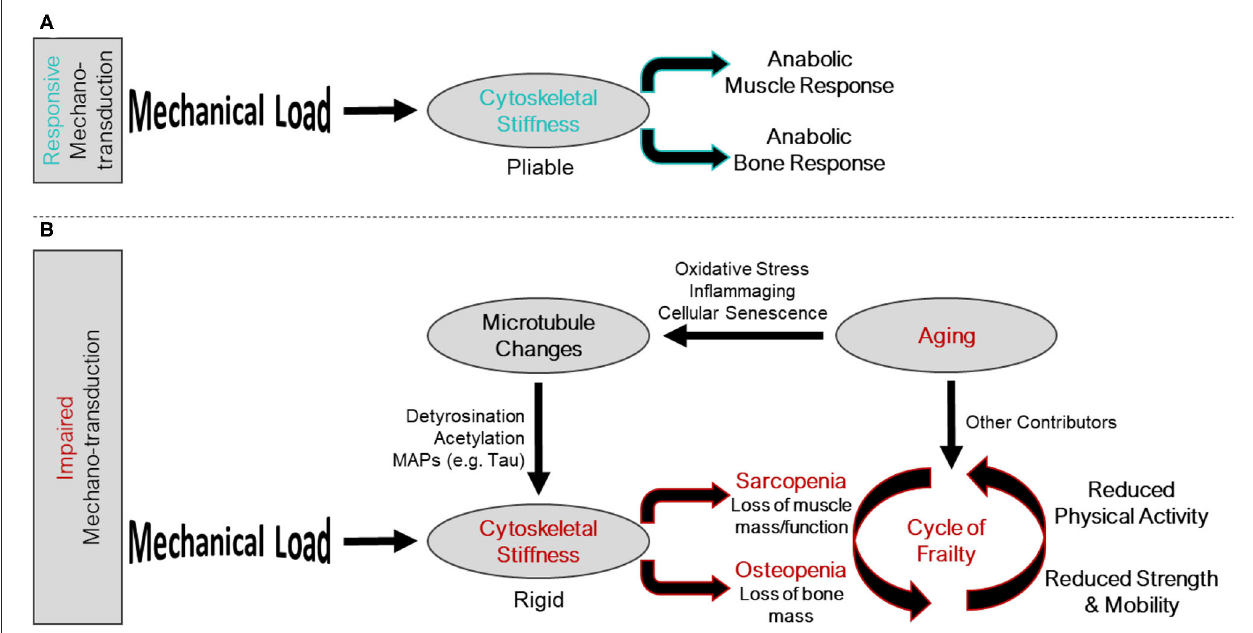
FIGURE 1 | Intersection of the mechano-transduction pathway and the cycle of frailty. (A) Responsive mechano-transduction in youth. Mechanical load is sensed by a pliable cytoskeleton initiating the anabolic responses of both muscle and bone. (B) Impaired mechano-transduction in aging. Mechanical load is sensed by a rigid cytoskeleton, influenced by changes to the microtubule network, a consequence of aging related phenomena, leading to sarcopenia and osteopenia. These musculoskeletal pathologies feed into the cycle of frailty, where reduced strength and mobility, and reduced physical activity propagate the feed forward